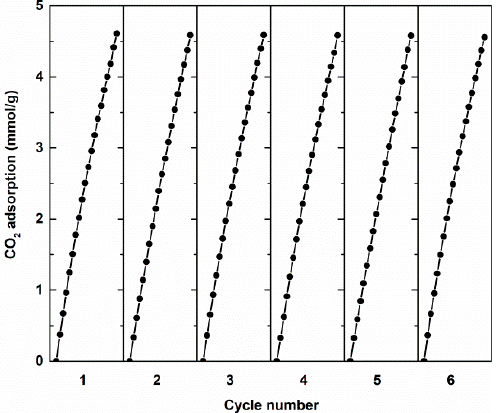
Figure 11. Recycle test of CO 2 adsorption on 1Li@NH 2 –MIL125(Ti) at 293 K.